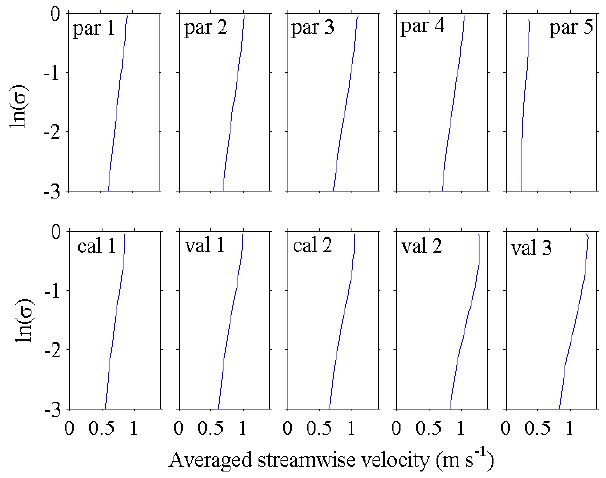
Fig. 5. Velocity profiles averaged over the middle part of the river section ( β = 0 . 35 − 0 . 65) during the ADCP surveys.